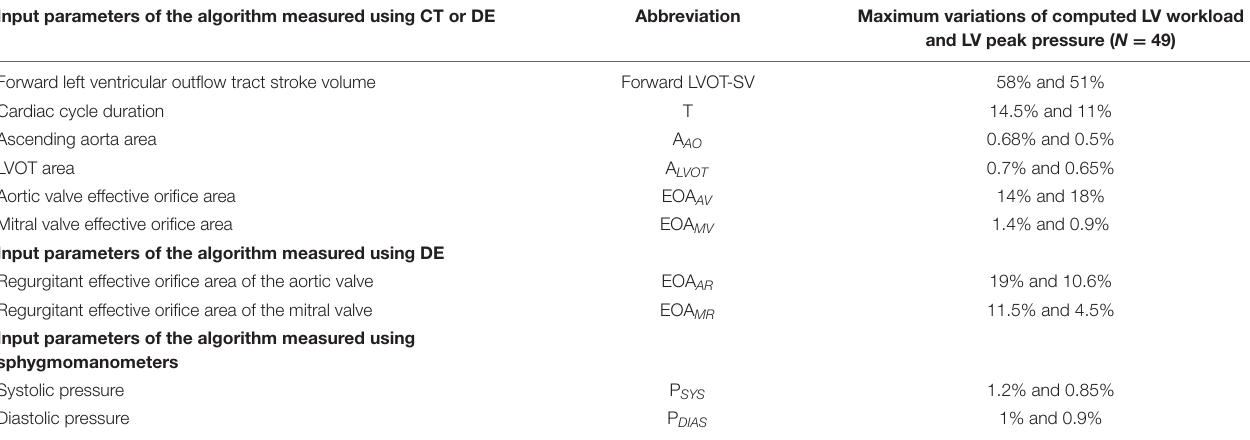
TABLE 3 | Maximum variation of the computed LV workload and LV peak